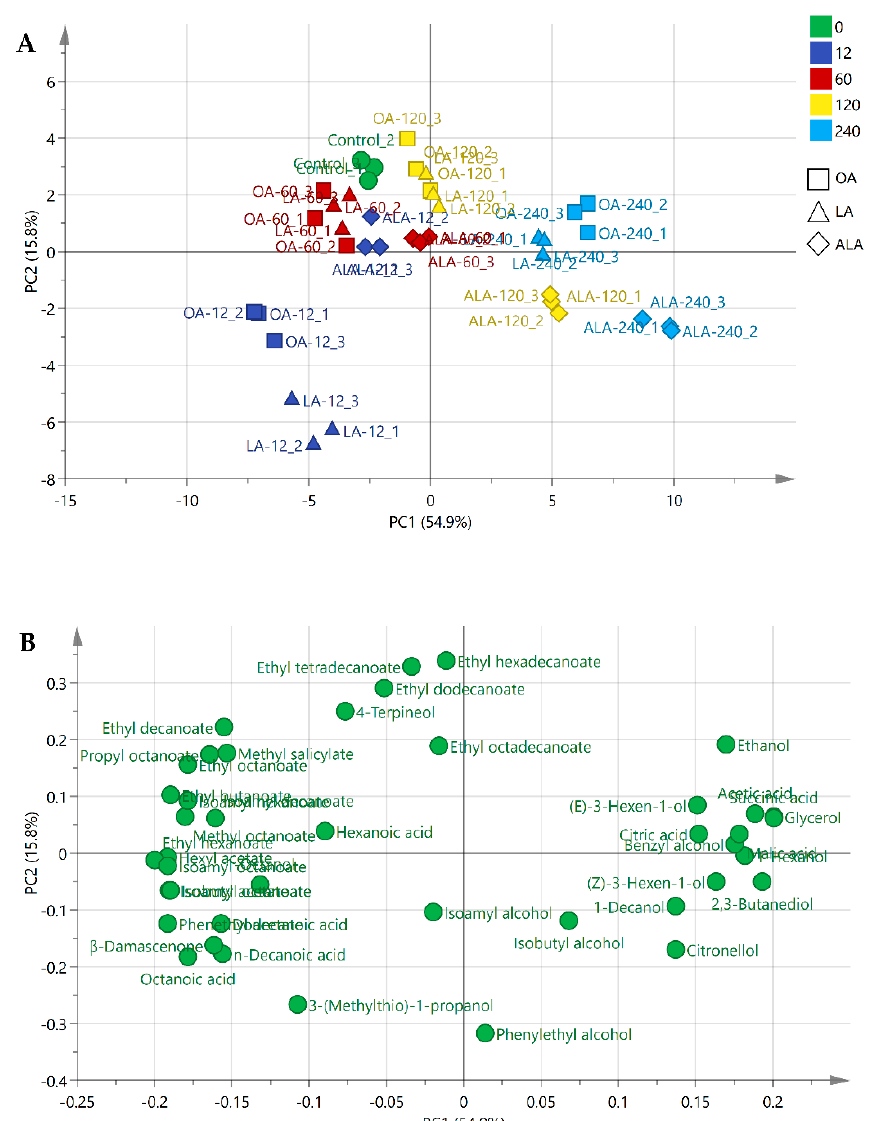
Figure 4. Principal component analysis (PCA) score plot ( A ) and loadings plot ( B ) using 36 volatile compounds and main fermentation products (including ethanol, glycerol, acetic acid, citric acid, malic acid, and succinic acid) in the Control (green circle), 12 mg/L (blue), 60 mg/L (red), 120 mg/L (yellow), and 240 mg/L mg/L (light blue) addition of oleic acid (OA, square), linoleic acid (LA, triangle), and α -linolenic acid (ALA, diamond).